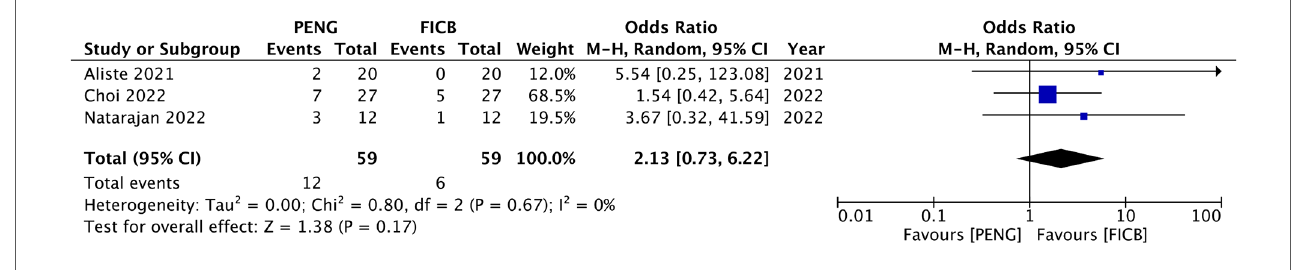
FIGURE 5 Meta-analysis of PONV between PENG and FICB groups.